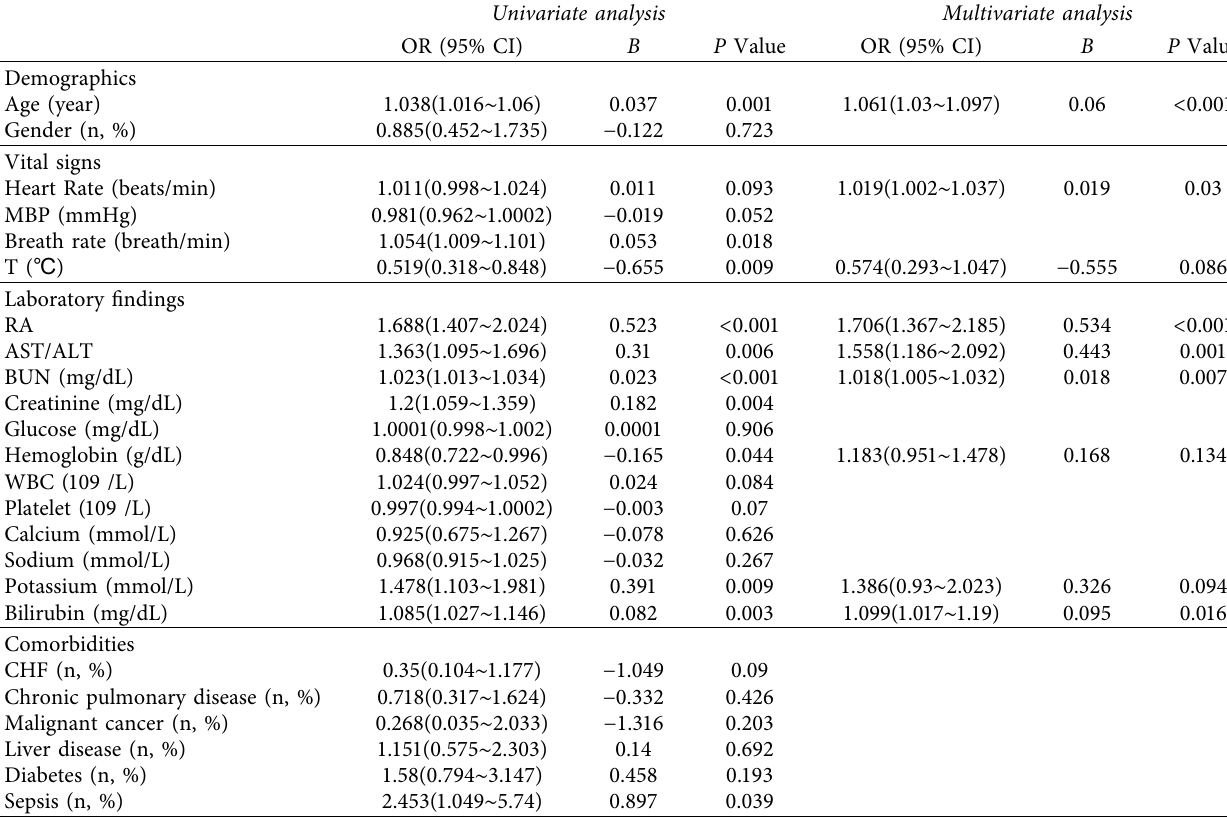
Table 2: Univariate and multivariate logistic regression analysis in patients with acute pancreatitis. Univariate